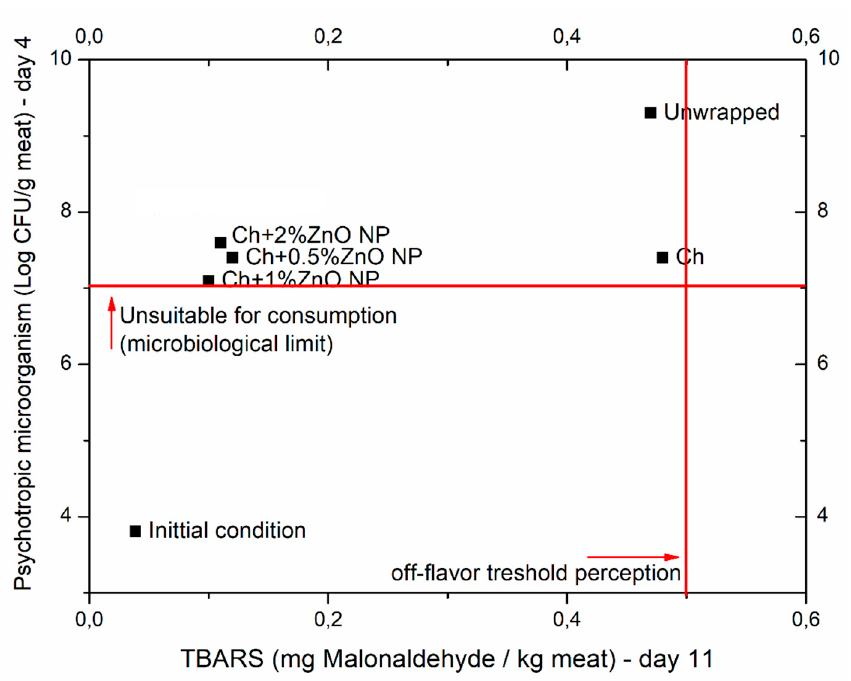
Figure 3. Plot of lipid oxidation and microbiology study results of poultry meat packaged in chitosan (Ch)-based film incorporated with different levels of zinc oxide nanoparticles (ZnO NP) over the shelf-life time.